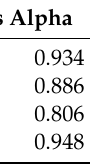
The bold text is necessary for distinguishing the variables from the results. Table A3. Results of Varimax rotation (Varimax rotation matrix).